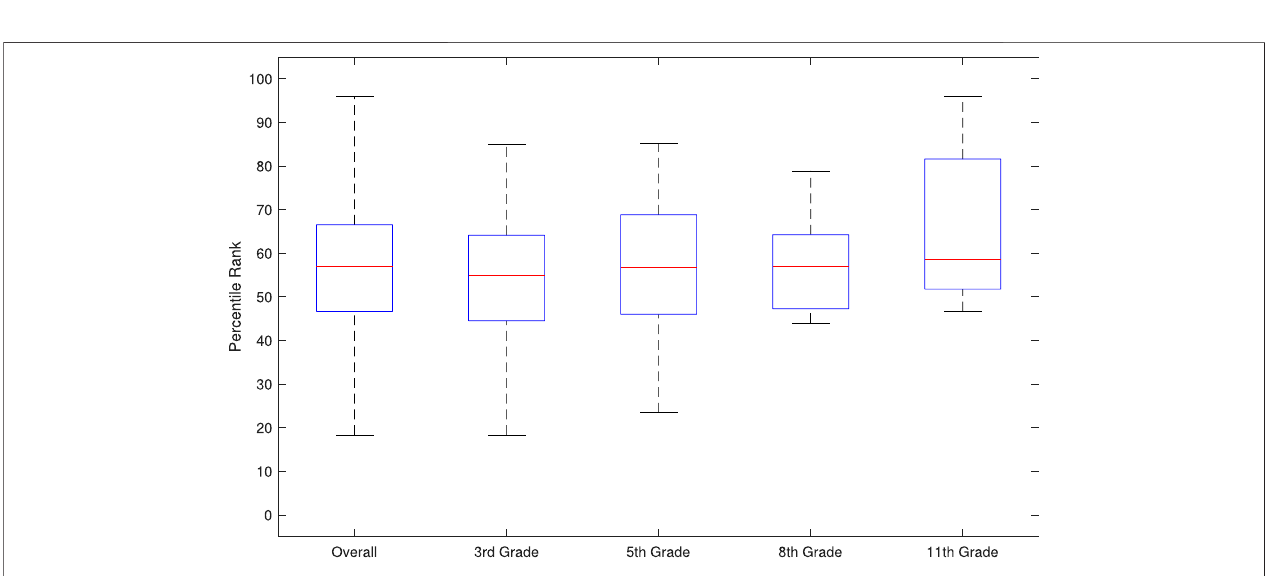
FIGURE 4 | Box plot of the math achievement scores in terms of percentile ranks, averaged for each classroom ( n (cid:1) 178), shown by grade.